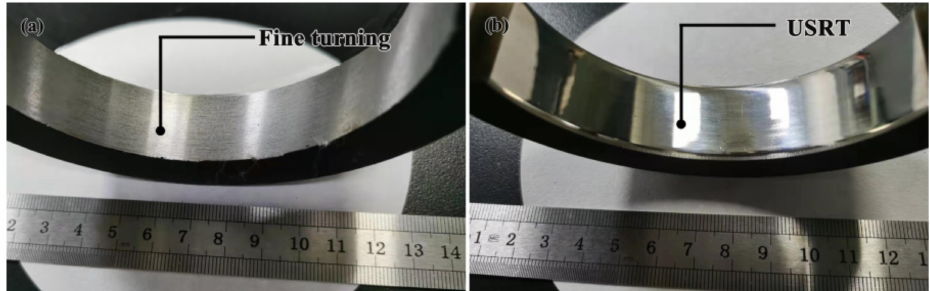
Figure 2. Comparison of the surface quality of AISI 304 stainless steel before ( a ) and after ( b ) the USRT